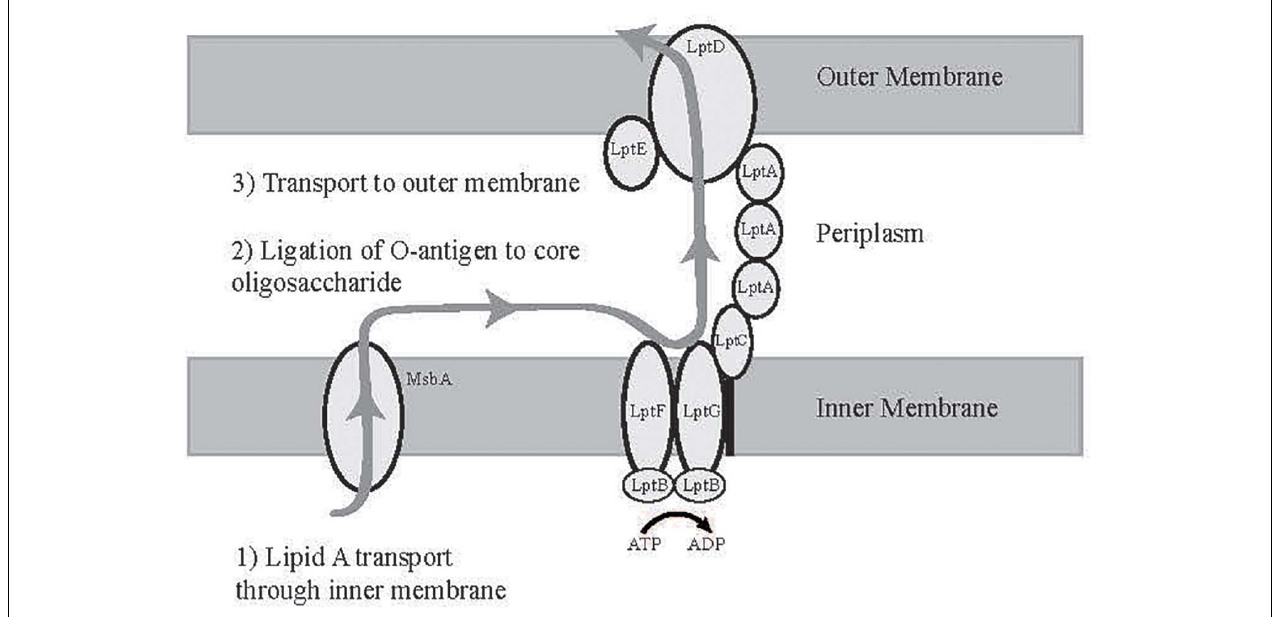
FIGURE 1 | Diagram of LPS transport to the outer membrane. Lipid A is synthesized at the cytoplasmic face of the inner membrane and transported to the periplasm by MsbA, ligated to O-antigen, and then transported to the outer membrane by the Lipopolysaccharide Transport Proteins (LptA-F) (Whitfield and Trent, 2014).